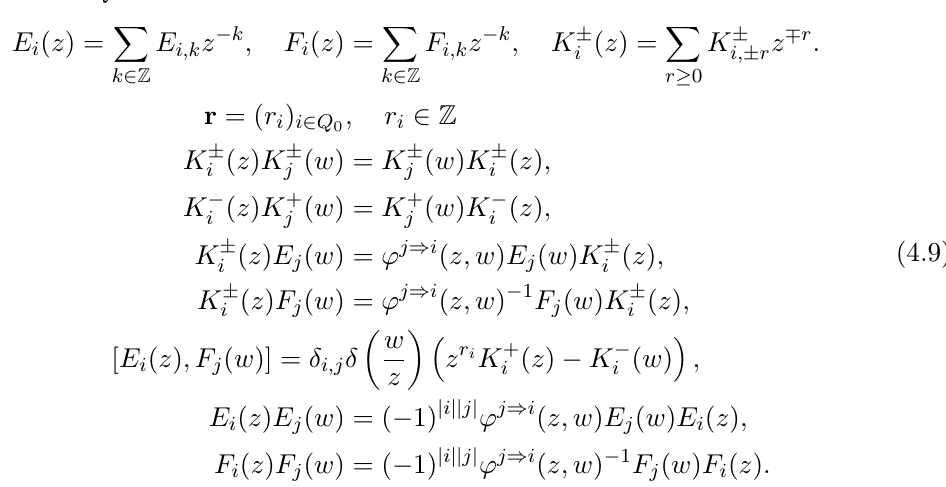
C2. The one-dimensional crystal is the region surrounded by two parallel zig-zag